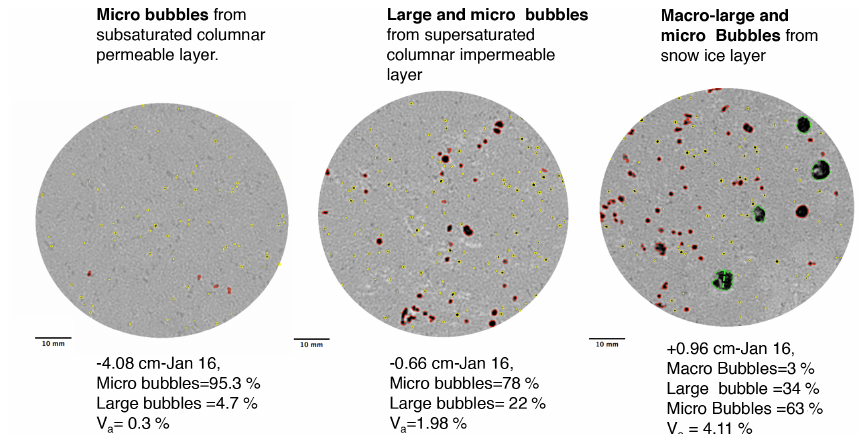
Figure 8. Transversal slice at different depth highlighting the proportion of micro (yellow), large (red) and macro (green) bubbles in each slice (e.g., [Nbr micro/(Nbr micro + NbrLarge + Nbr Macro)] × 100).